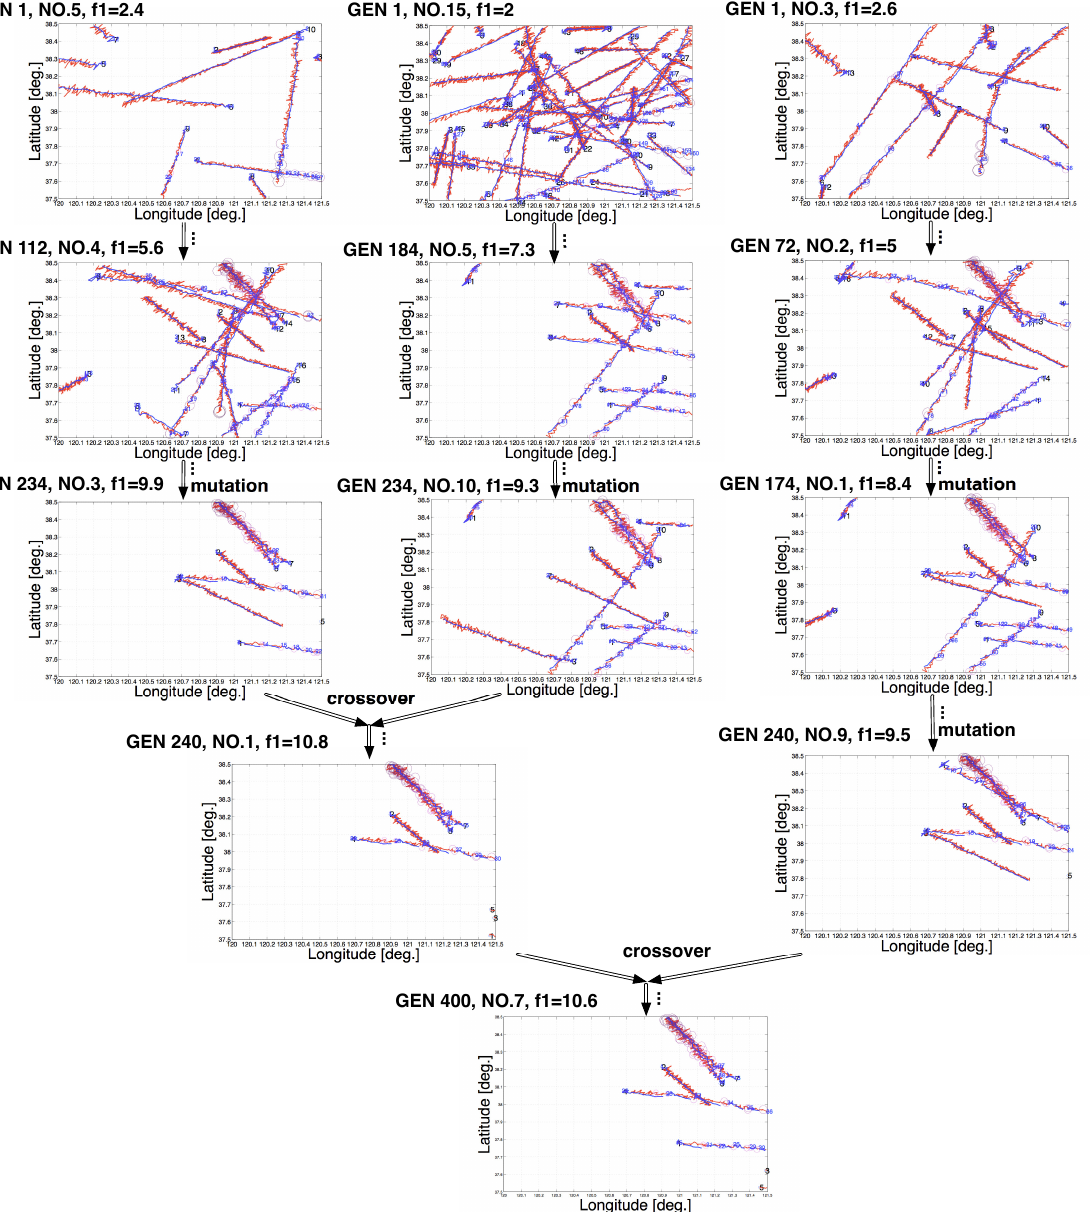
Figure 9. Partial family tree of an evolved scenario (with noise): the directed lines point from one scenario to its descendant(s) generated from genetic operations such as crossover and mutation as the evolutionary process proceeds; the labels on the directed lines denote the specific genetic operations implemented to produce the descendant(s), in which “...” denotes ellipsis in the full family tree due to the space limit; GEN denotes the generation label of the evolutionary process of the scenario, where the bigger is the GEN, the more evolved is the scenario; No. denotes the individual label of the scenario in the population; and f 1 shows the fitness value of this